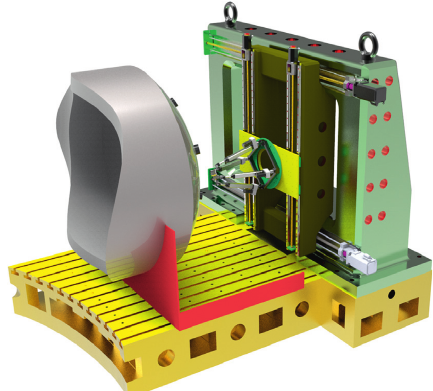
Figure 1: A five-axis hybrid kinematic machine